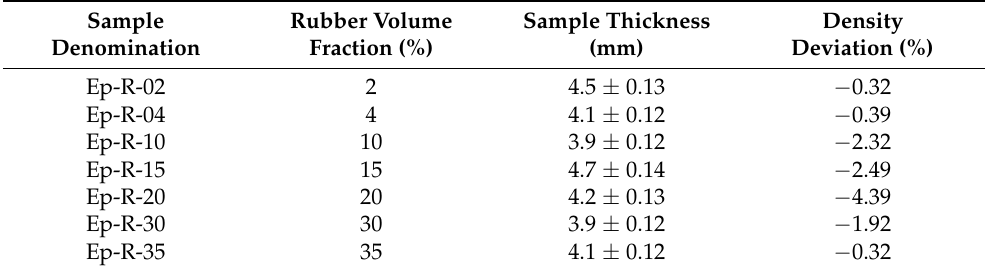
Table 5. Rubber-powder-loaded epoxy resin